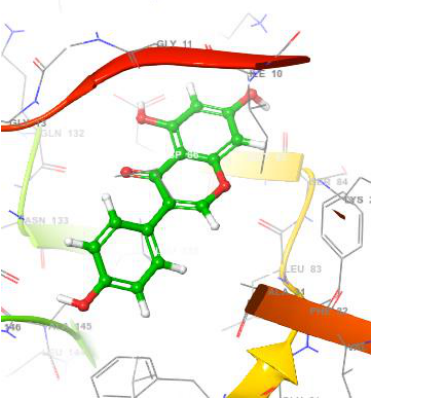
Table 2. Interactions of 6GU7 with curcumin, quercetin, withanolide, and genistein. Curcumin